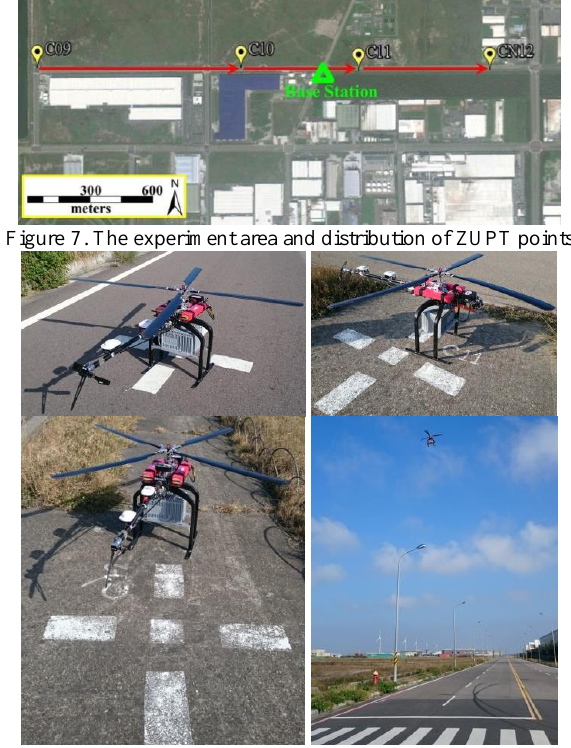
Figure 8. The measure method in the experiment